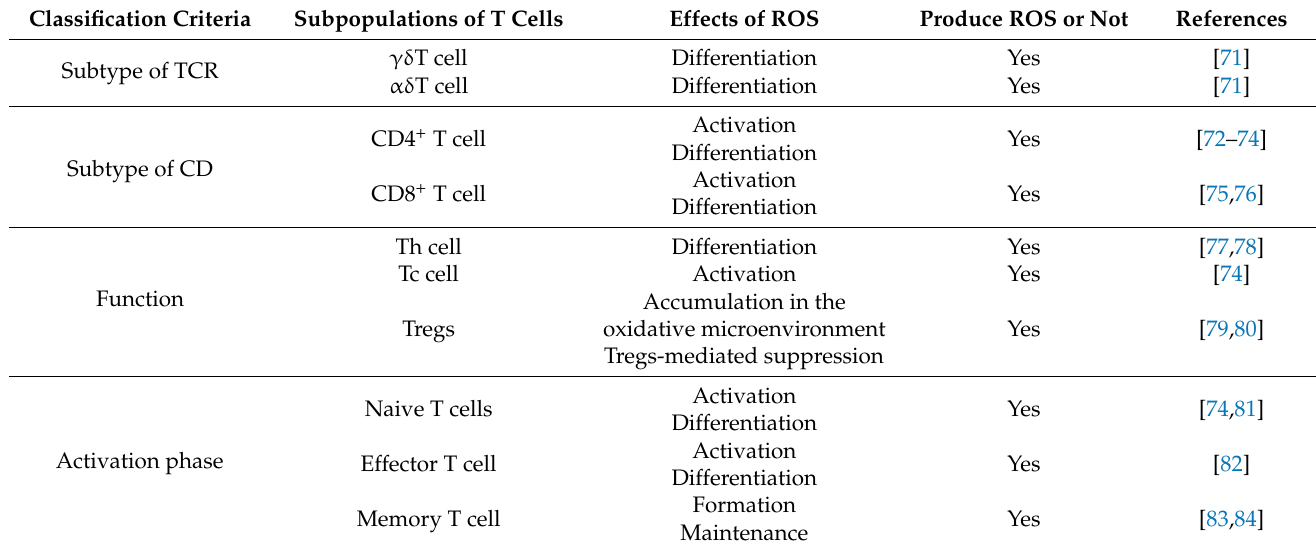
Table 1. Summary of ROS effects in different subpopulations of T cells. Classification